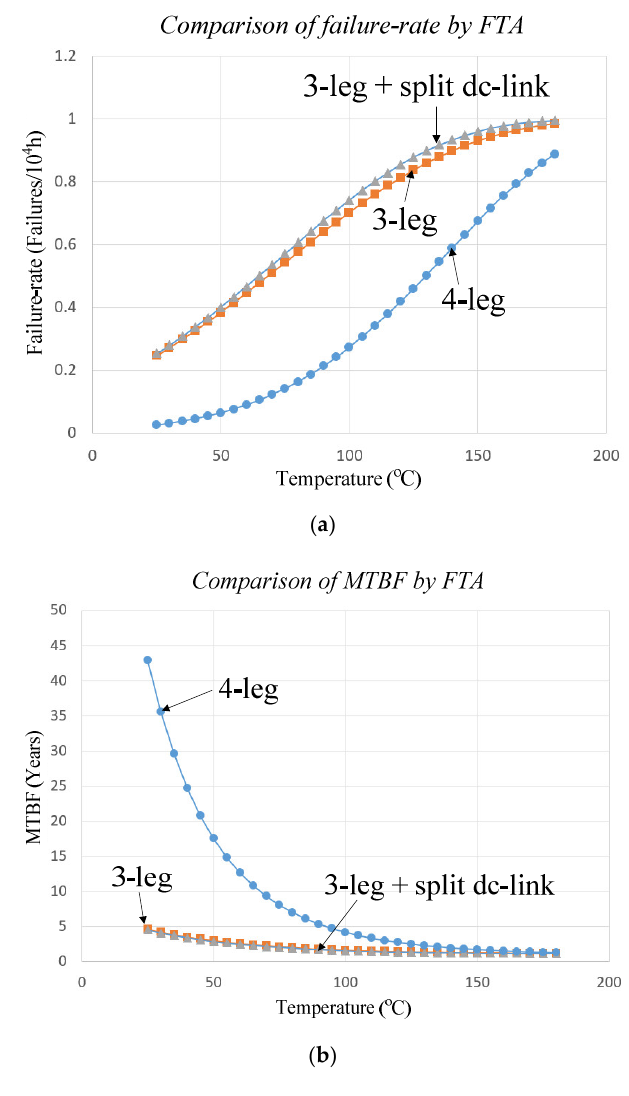
Figure 13. Comparison of failure rate and MTBF by fault-tree analysis (FTA): ( a ) Failure rate; ( b ) mean time between failures, year.